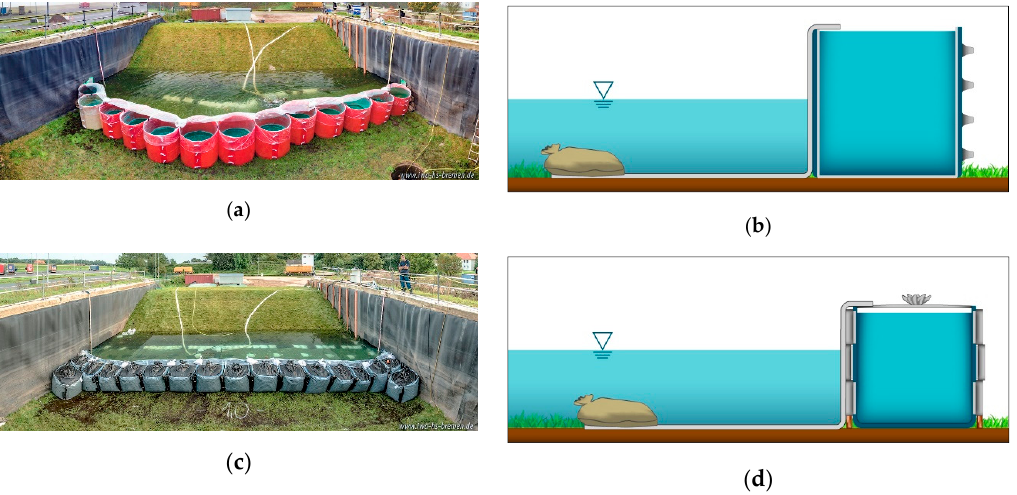
Figure 4 Basin systems tested in the IWA test facility, (a) AQUARIWA (water-filled), (b) schematic diagram of the AQUARIWA system, (c) INDUTAINER, (water-filled), (d) schematic diagram of the INDUTAINER system